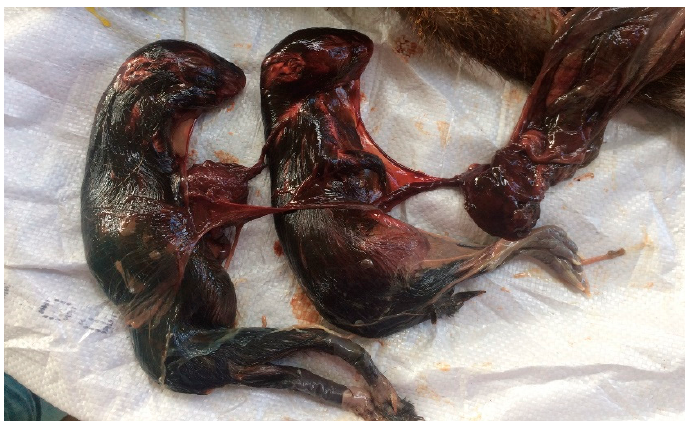
Figure 2. Two offspring weighing 200 g each in the uterus. Figure 2. Two o ff spring weighing 200 g each in the